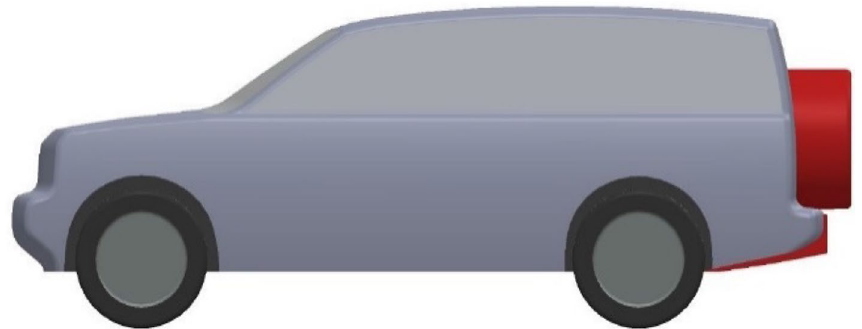
Figure 12. Back view of modified LRD4 with the spare tire.